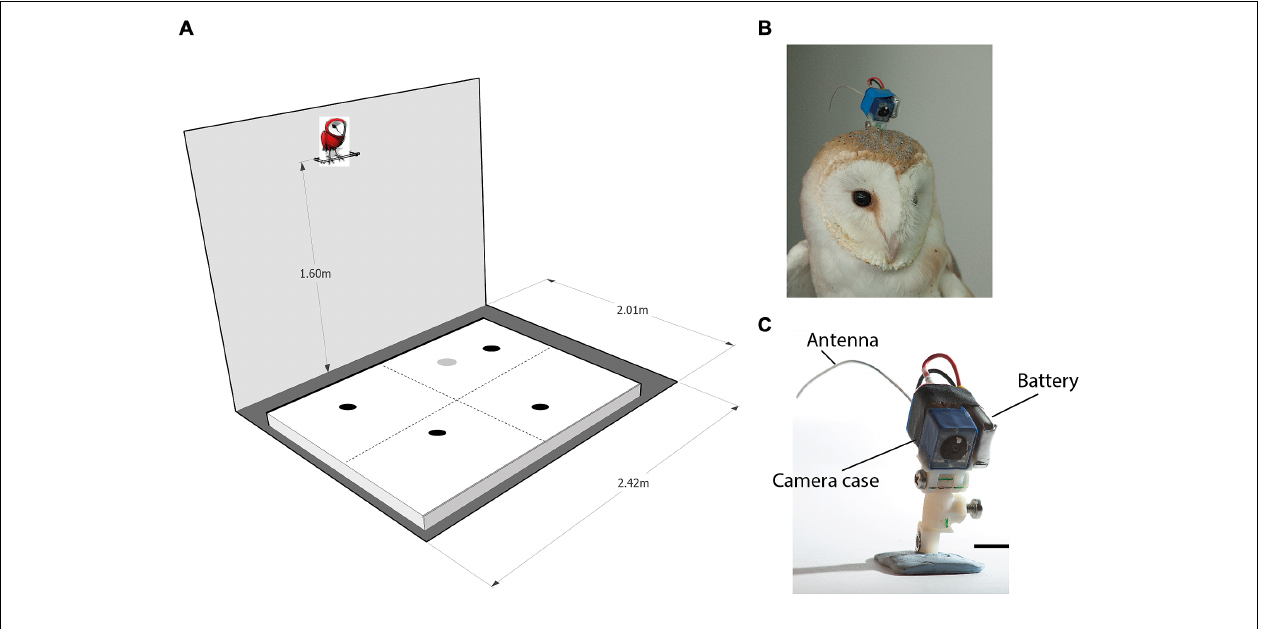
on the arena designate possible positions of four food items. Items were spread so that each quadrant will contain one item.The gray spot on the arena designates a possible location of the loud speaker. (B) An owl with the OwlCam attached to its head. (C) A close view of the OwlCam with the attachment unit and the battery in place.The scale bar designates 10